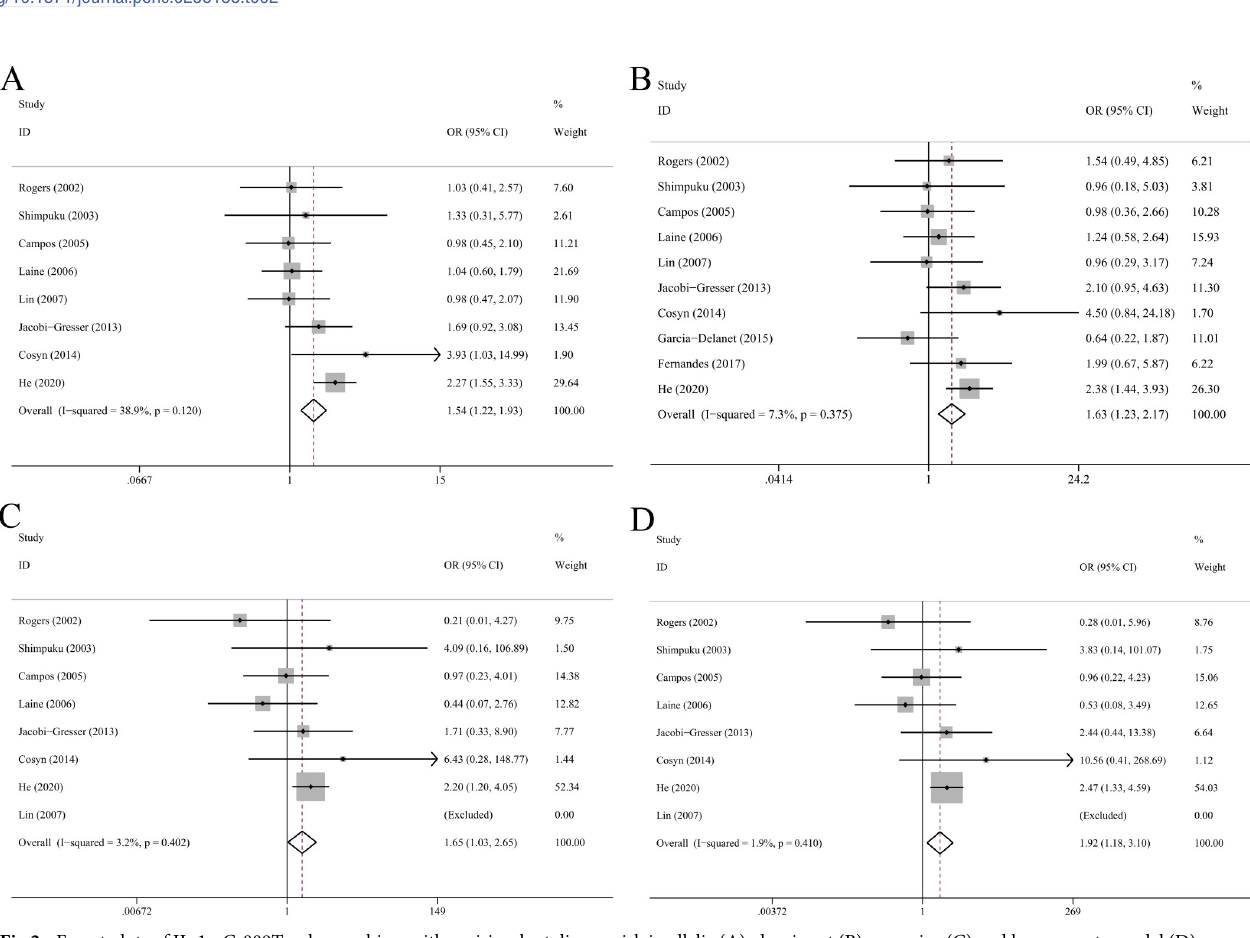
PLOS ONE | https://doi.org/10.1371/journal.pone.0258138 October 5,